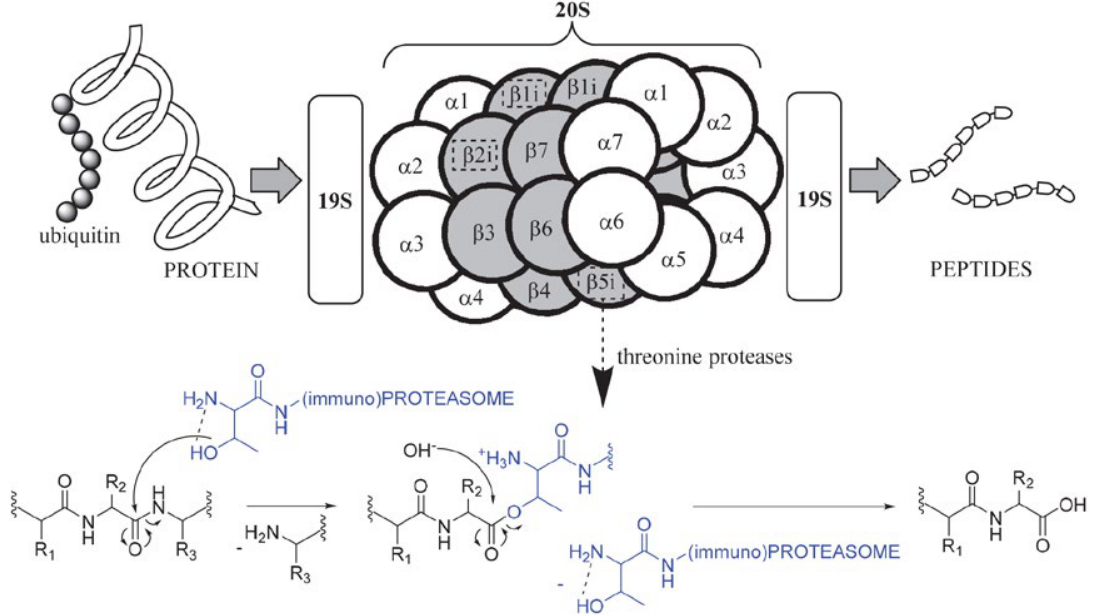
Figure 1. Proteasome (immunoproteasome) assembly with β1i (caspase-like), β2i (trypsin-like) and β5i (chymotrypsin-like) N-terminal threonine